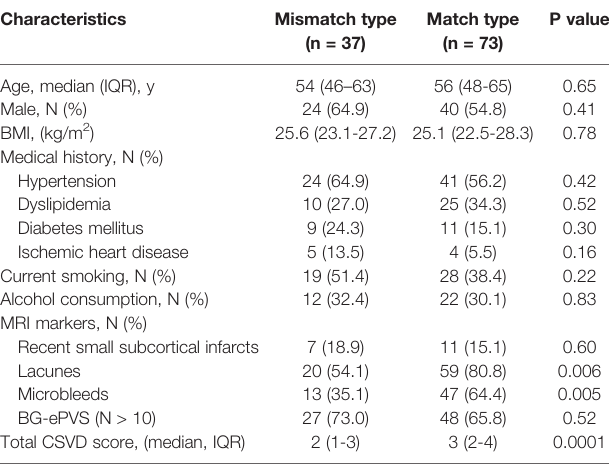
TABLE 3 | Comparison of clinical and imaging factors between mismatch and match types. Characteristics